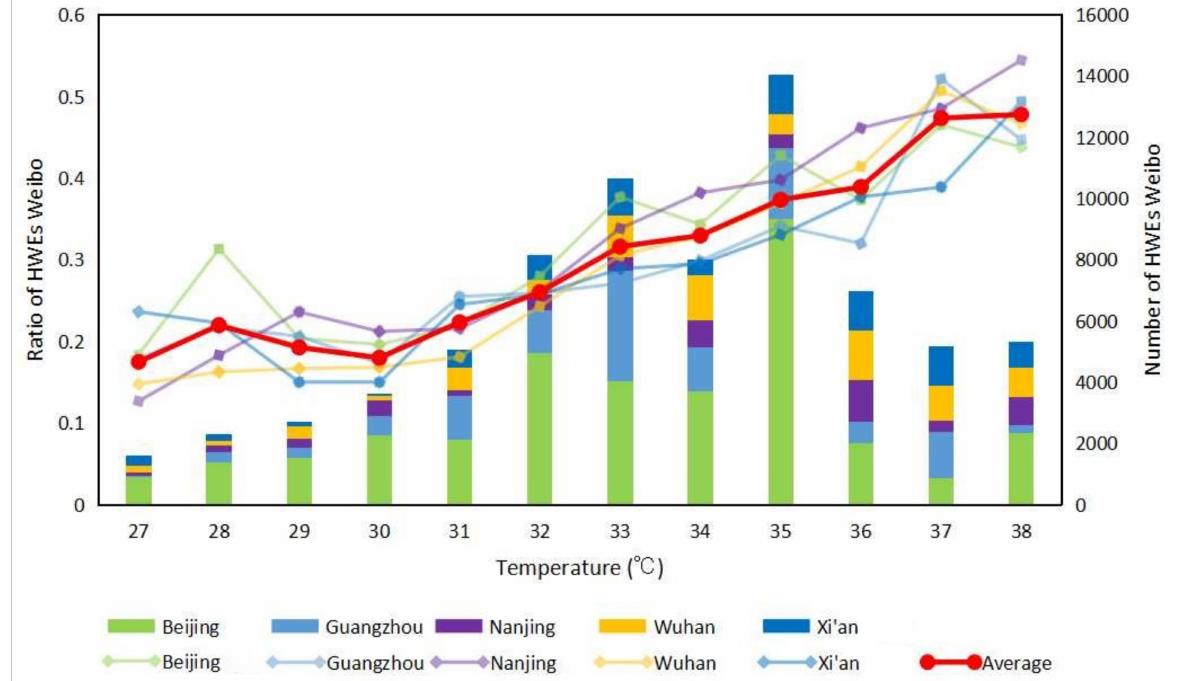
Figure 5. Trend in urban residential sensitivity in Weibo space with